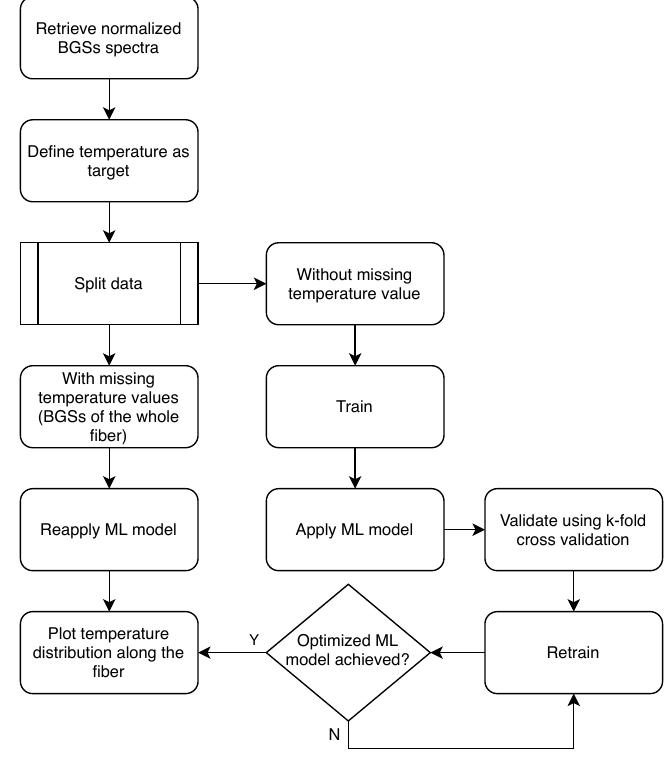
Figure 1. The flowchart in building an ML